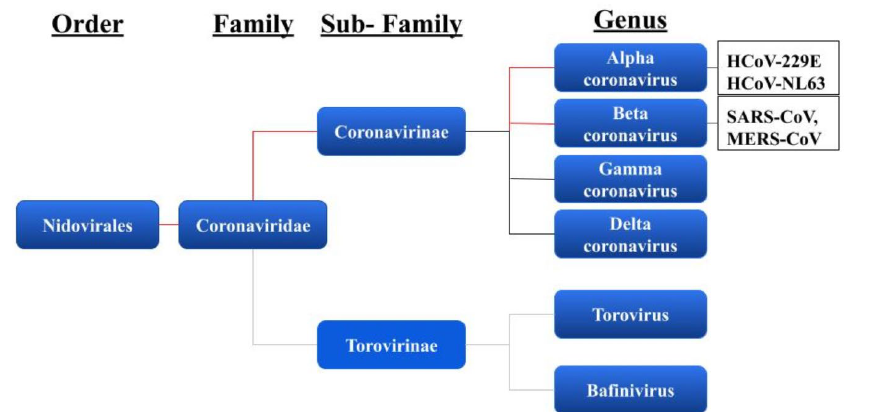
Fig. 1. Schematic portrayal of Coronaviridae